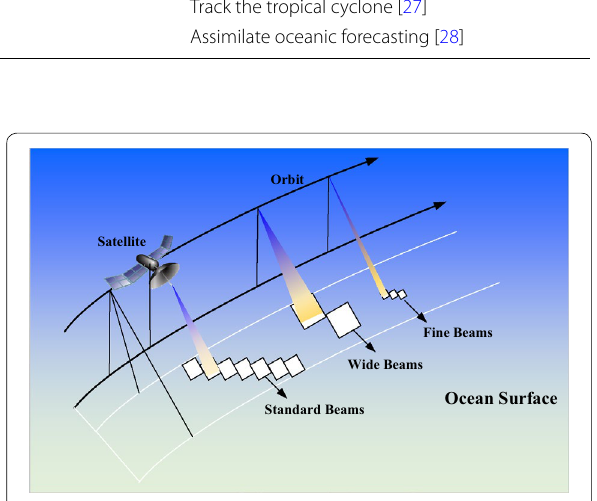
Figure 3 Remote sensing by the